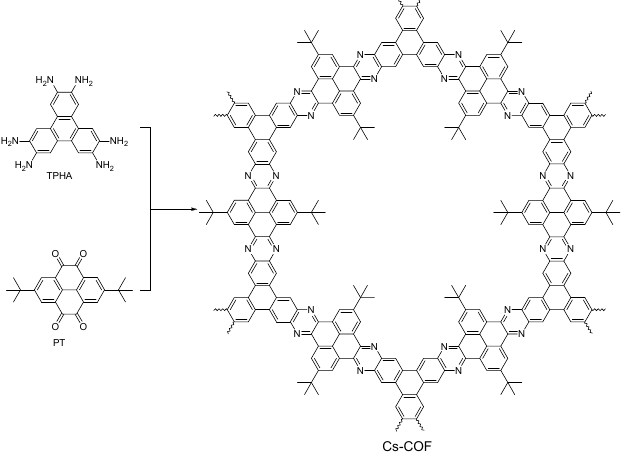
Figure 23. Synthetic reaction of the phenazine-linked COF.